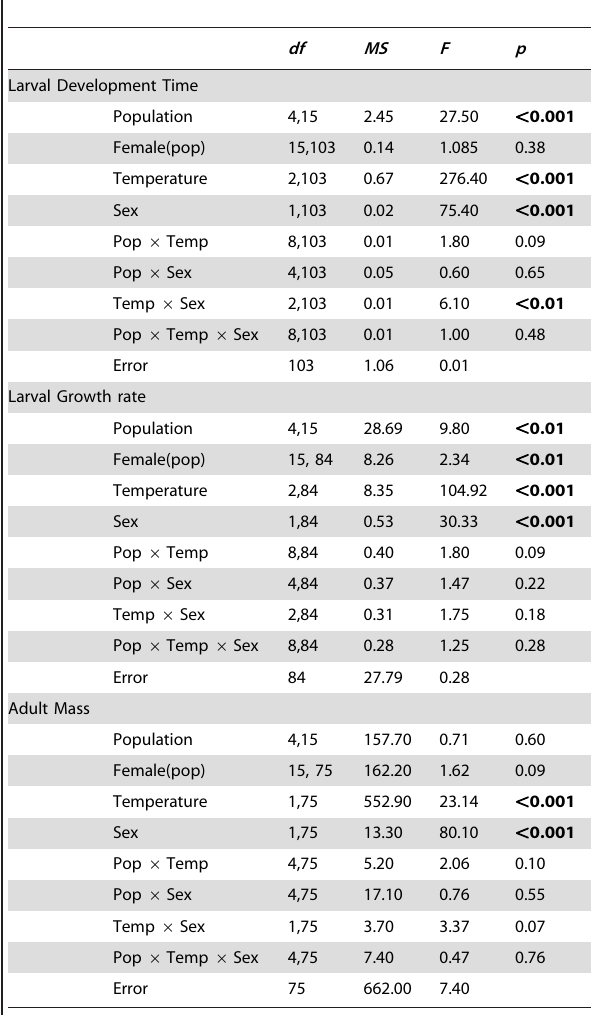
Table 2. Impacts of temperature, sex and population on fitness